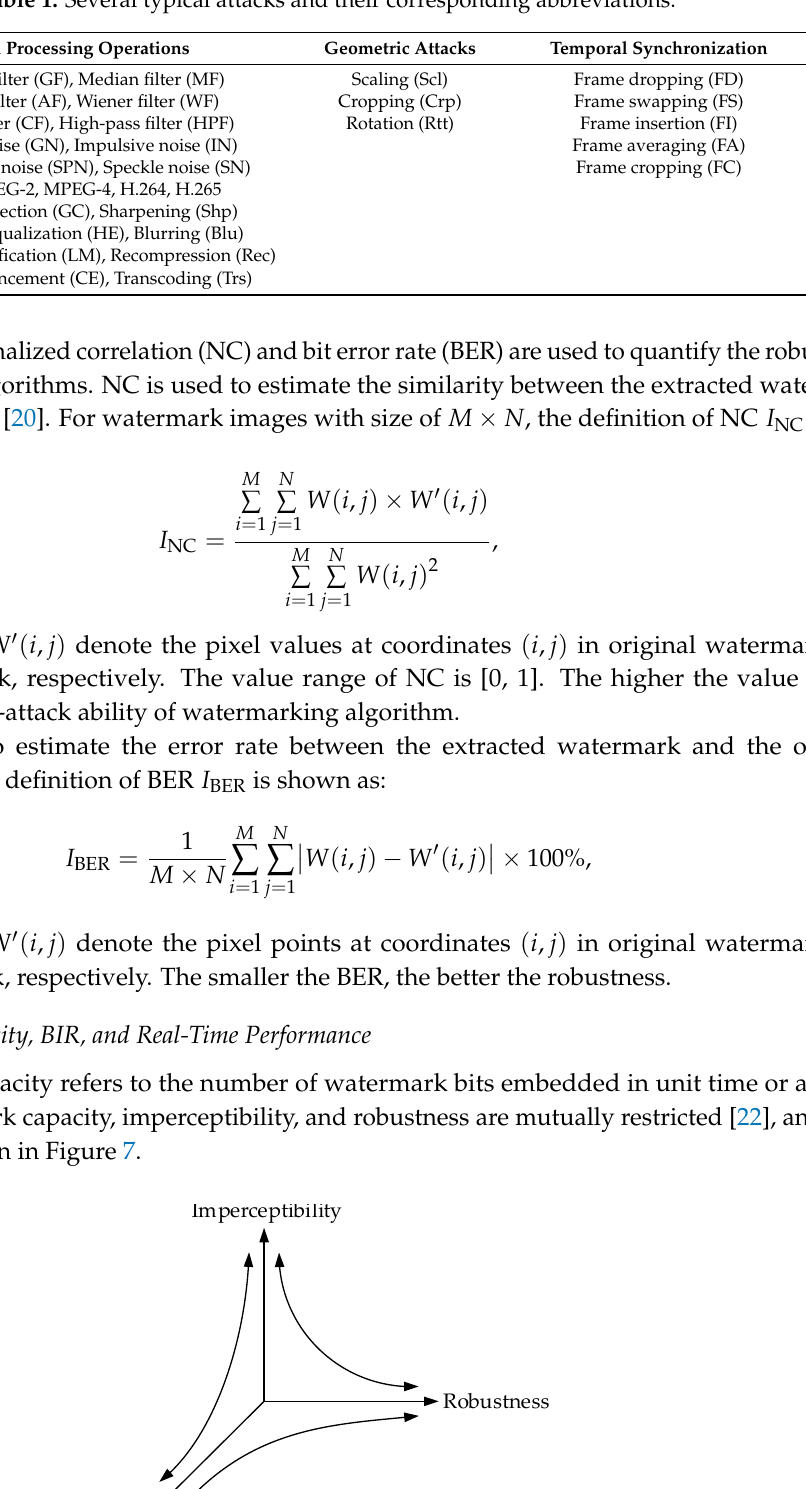
Table 1. Several typical attacks and their corresponding abbreviations.